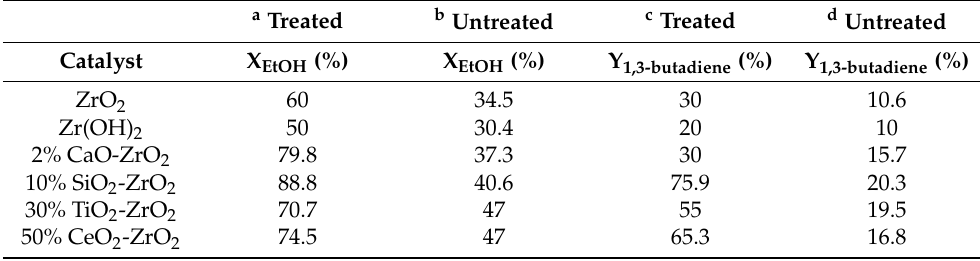
Table 6. Performance summary of treated and untreated commercial catalyst at 350 ◦ C. a